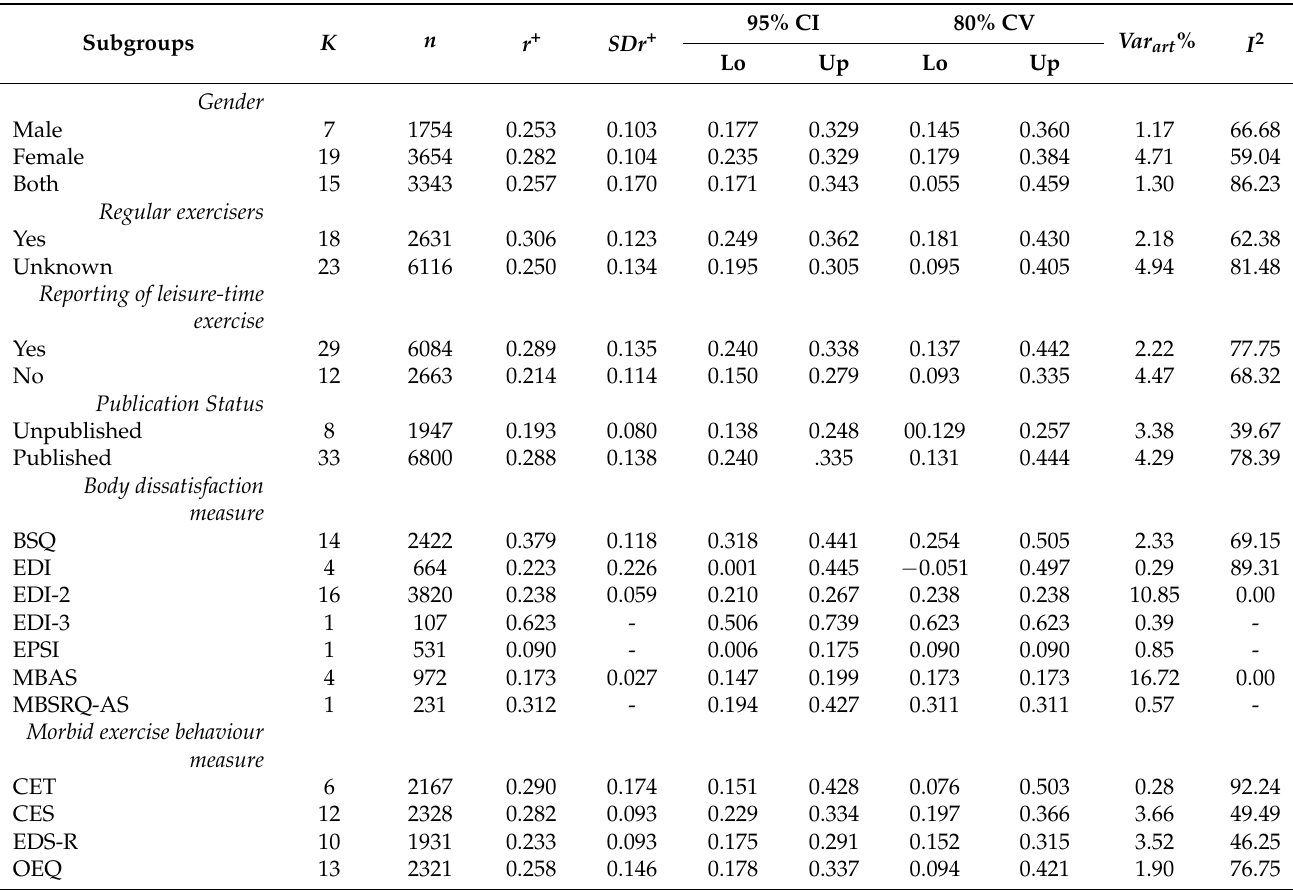
Table 2. Results of subgroups